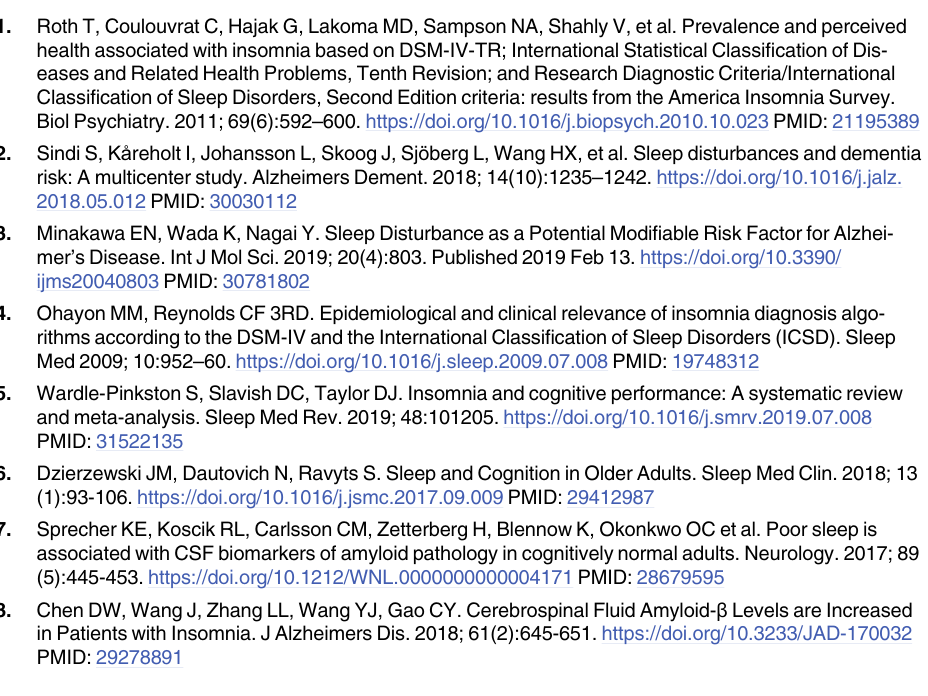
S2 Fig. Putamen volumes between insomnia and non-insomnia groups. Box plot showing the mean of the normalized volumes of right and left putamen in insomnia (ISI � 8) and non- insomnia (ISI � 7) subjects (n = 120). � Significance p < 0.05.